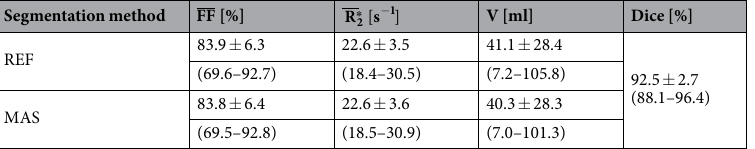
Table 2. Summary of segmentation results. Data on cervical-supraclavicular adipose tissue (considered as suspected brown adipose tissue, denoted sBAT). Measurements of mean fat fraction (FF) , mean R 2 * ⁎ ( R ) volume (V) of segmented sBAT, obtained by the multi-atlas segmentation (MAS) method and the semi- automated reference segmentation (REF) method. Segmentation overlap was estimated by the dice similarity coefficient (Dice). Measurements reported as group means ± standard deviations (ranges) of individual